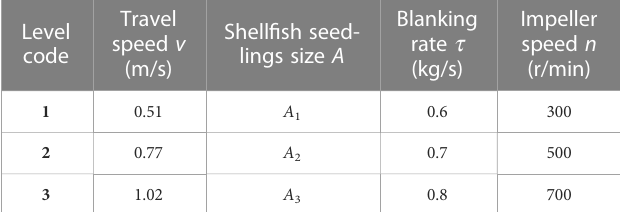
TABLE 10 Factor level coding table.